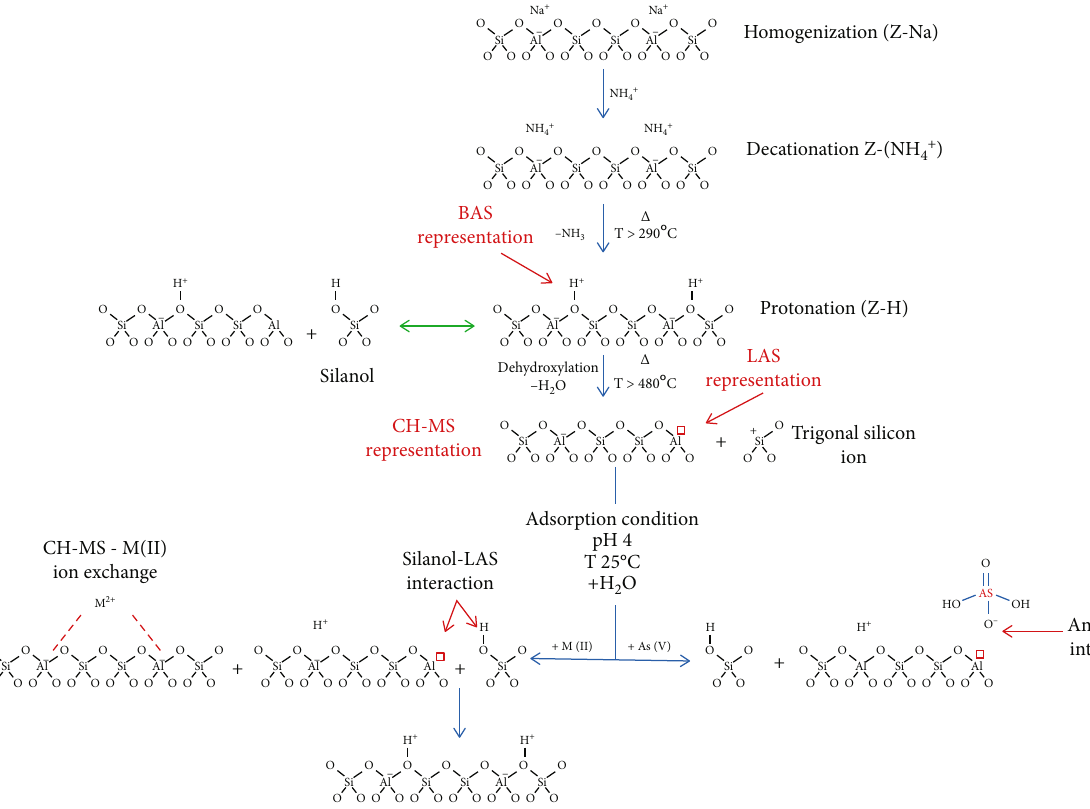
Figure 5: Illustrative 1D scheme of the stages of CH-N modi fi cation process where the formation of silanol, Brönsted acid sites (BAS), Lewis acid sites (LAS), and trigonal silicon ions is shown. The interaction of the CH-MS with divalent cations M(II) and anions like As(V). This fi gure was adapted from Uytterhoeven et al. [81] and Juzsakova et al. [45].